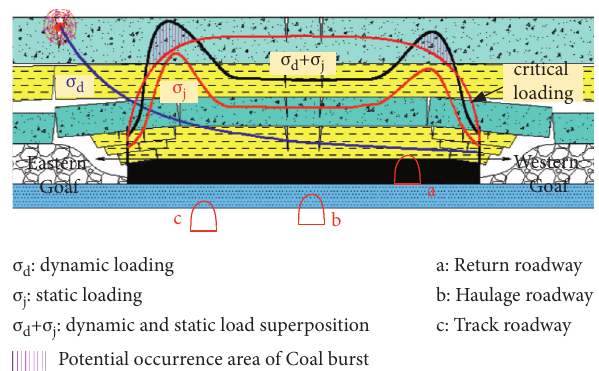
Figure 16: Dynamic and static load superimposed coal burst mechanism in the asymmetric isolated coal pillar